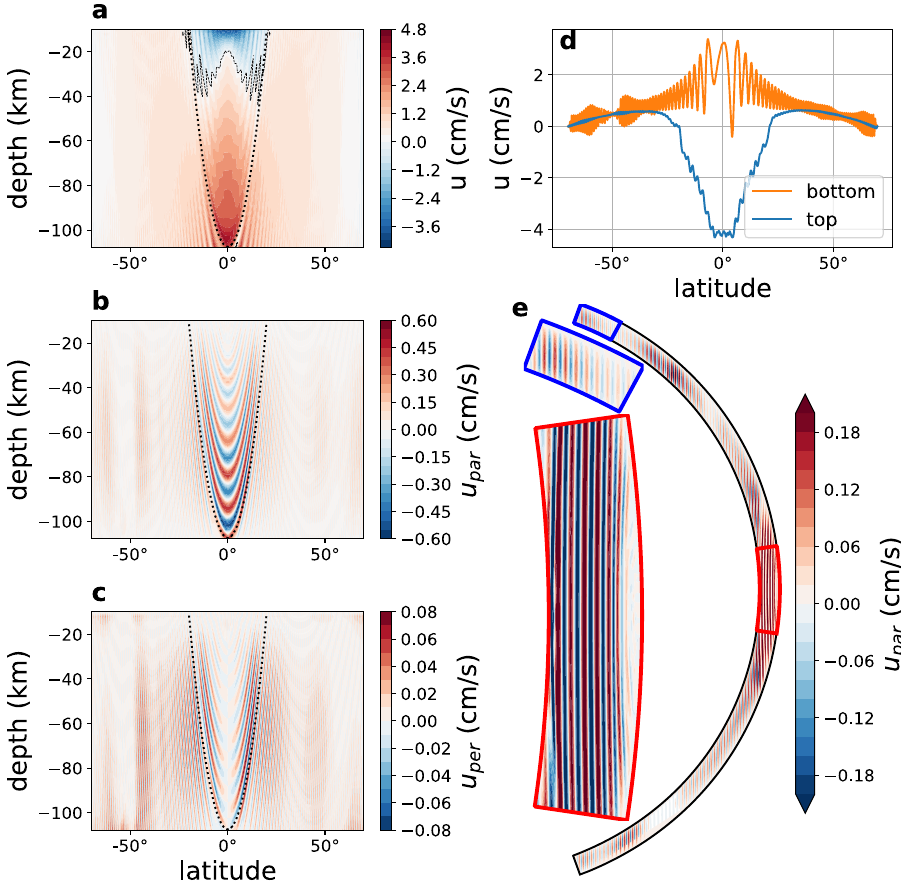
Fig. 2 2d simulation results — velocity. Latitude-depth snapshot plots of a zonal velocity (cm s − 1 , dashed line shows the zero contour), b velocity parallel to the axis of rotation, u par (cm s − 1 ), and c velocity perpendicular to the axis of rotation, u per (cm s − 1 ). The dotted lines in these panels shows the tangent cylinder. d Zonal velocity at the top and bottom of the ocean (cm s − 1 ) as a function of latitude. e The spherical presentation of the velocity parallel to the axis of rotation u par (also shown in b ), demonstrating Taylor columns that are parallel to the axis of rotation. The ocean depth extent is 100 km in all three frames shown, where the latitudinal extent of the main (black) frame is 70°S – 70°N, the low latitude (red) frame is 8°S – 8°N, and the high latitude (blue) frame is 61°N –